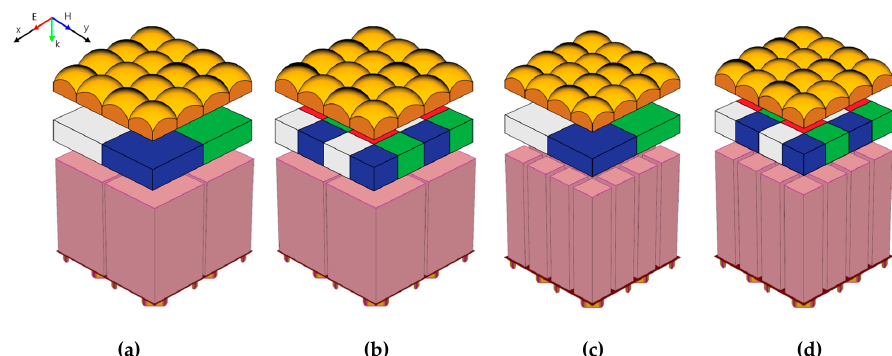
Figure 3. The simulated 3D Pixel structures. 4 × 4 pixel arrays. The microlens, CFA, and photodiodes are separated for ease of viewing. ( a ) Quad-Bayer CFA with DTI and WG, ( b ) Quad-Bayer CFA with S-DTI and S-WG, ( c ) Quad-WRGB CFA with DTI and WG, and ( d ) Quad-WRGB CFA with S-DTI and S-WG.